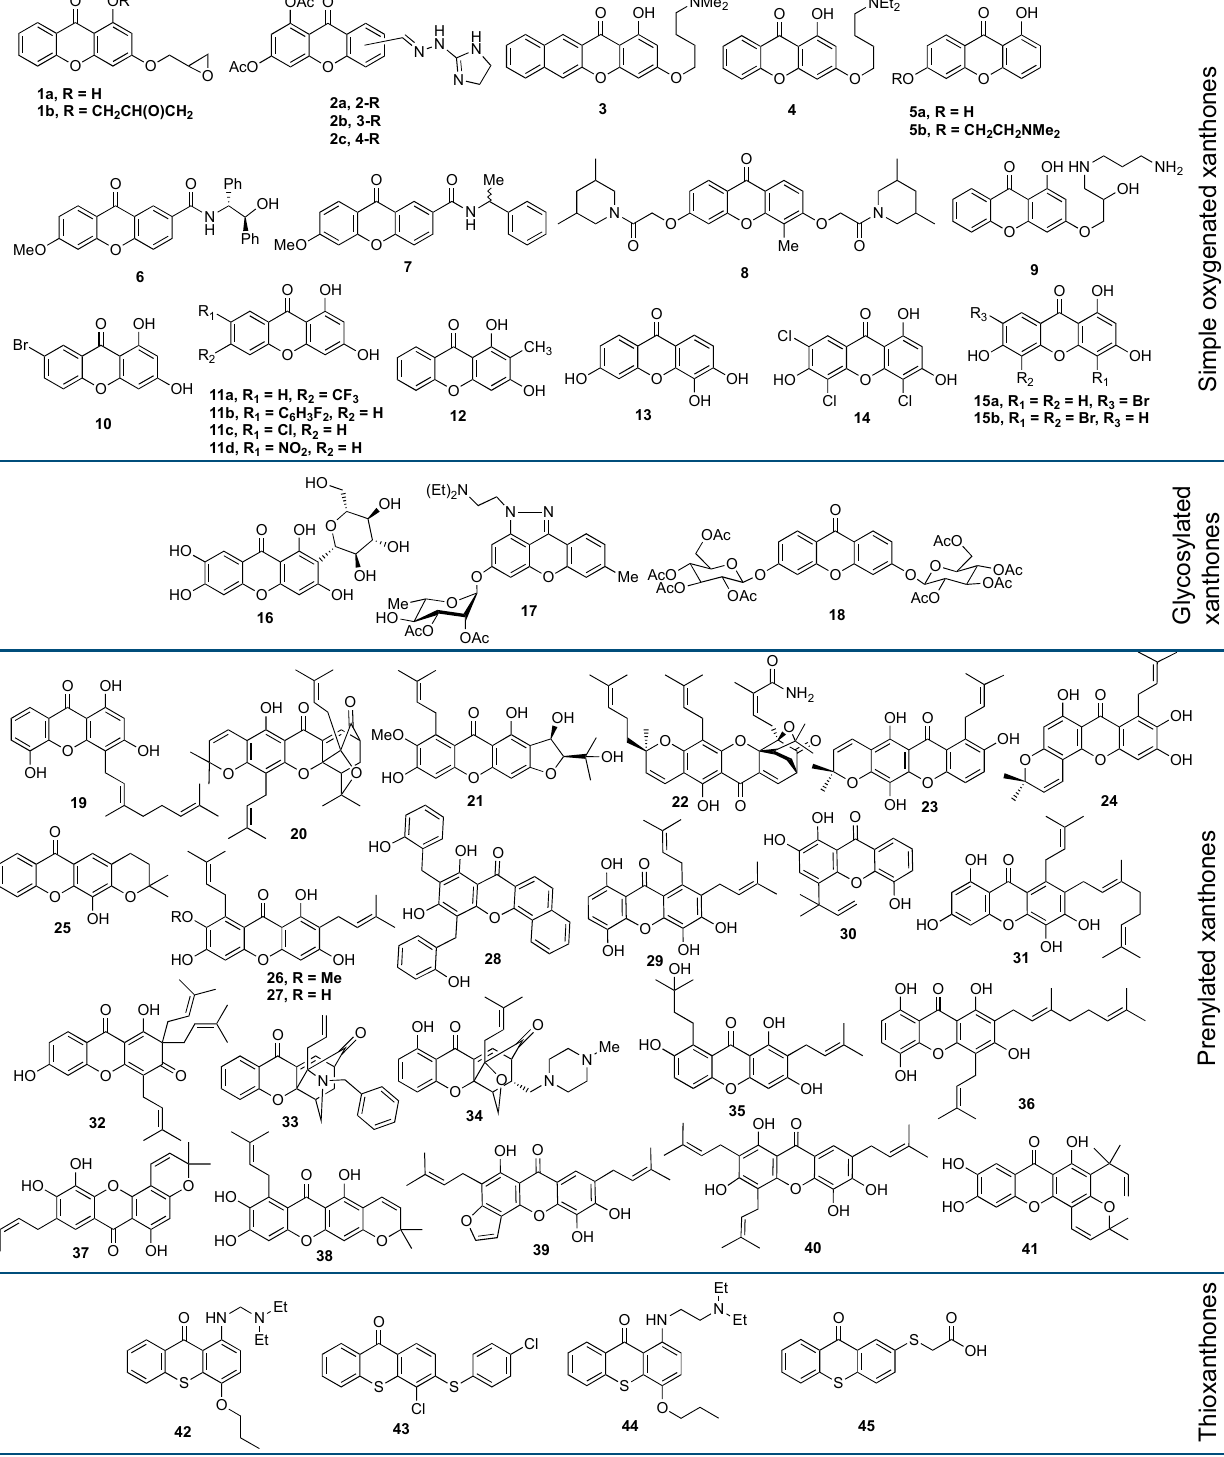
Figure 11. Evaluated xanthone derivatives as the anticancer agents through in vitro assay.